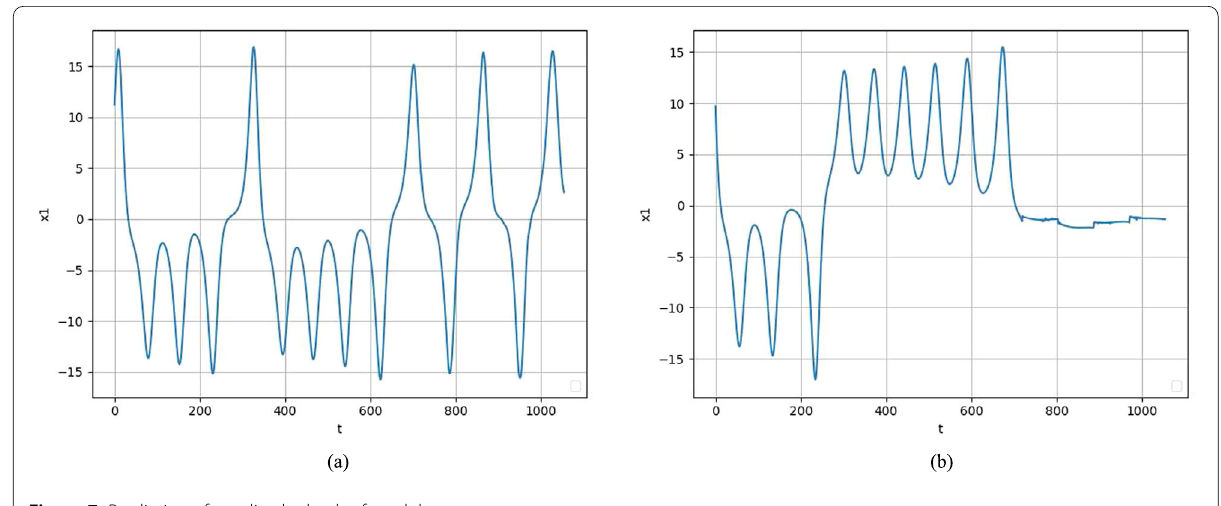
Figure 7 Prediction of amplitude death of models